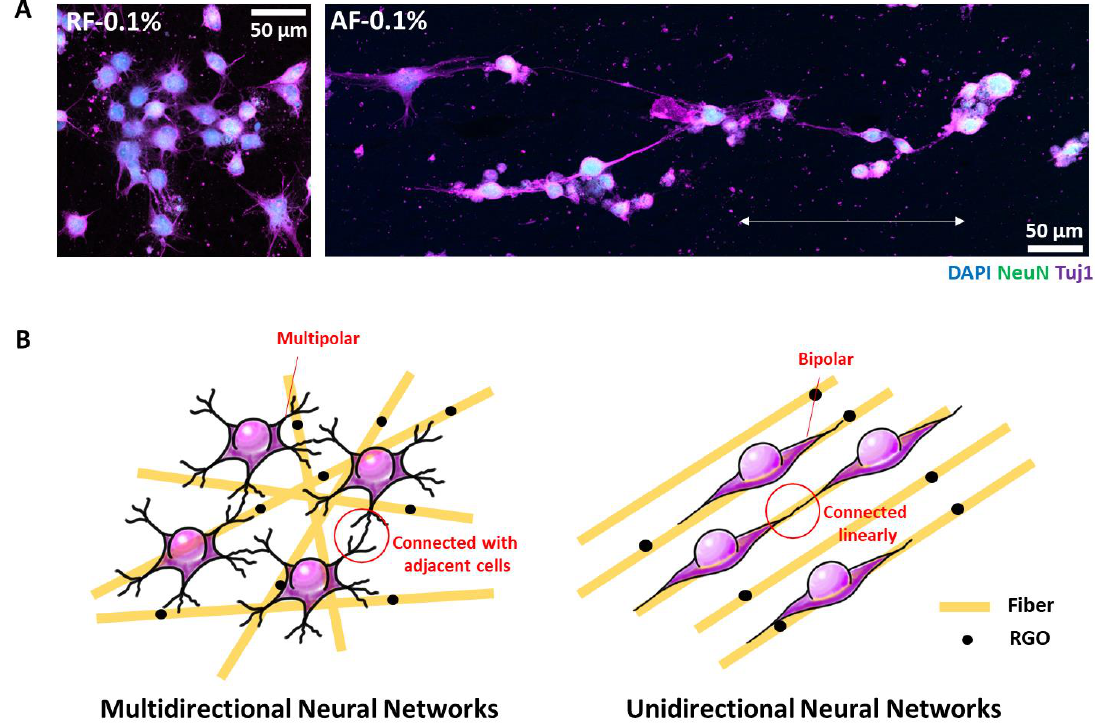
Figure 4. Effects of the RGO-PCL NF alignments on the conjunction of the differentiated DPSCs. ( A ) Comparison of neurites. Neurites differentiated from cells on RF-0.1% were connected with the adjacent cells, whereas those on AF-0.1% stretched and connected along the direction of the AF alignments. ( B ) Perspectives of the study. Because RF-0.1% can connect the differentiated cells with